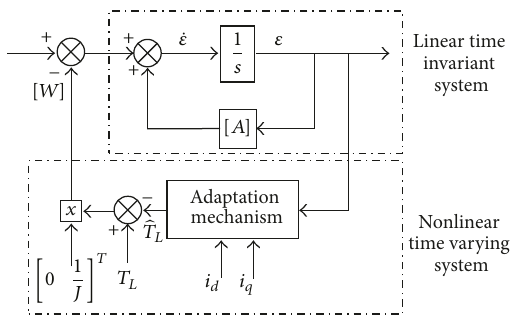
Figure 8: Block diagram of the proposed load torque